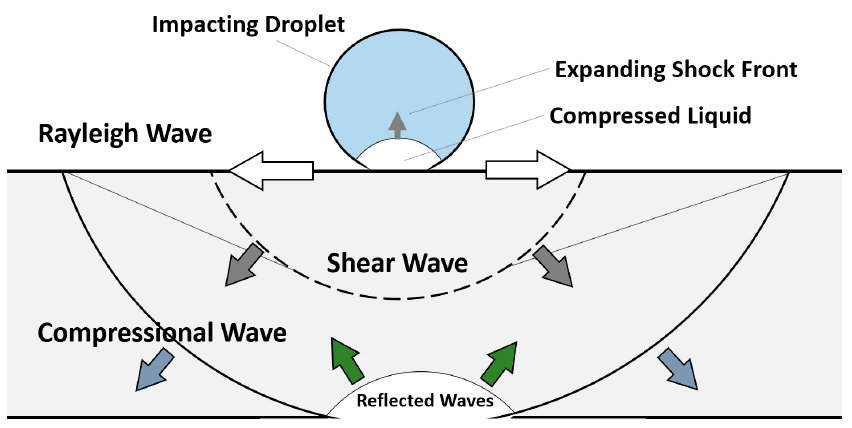
Figure 7. Schematic of shock wave behavior during the liquid droplet-solid surface interaction. Redrawn from [25].